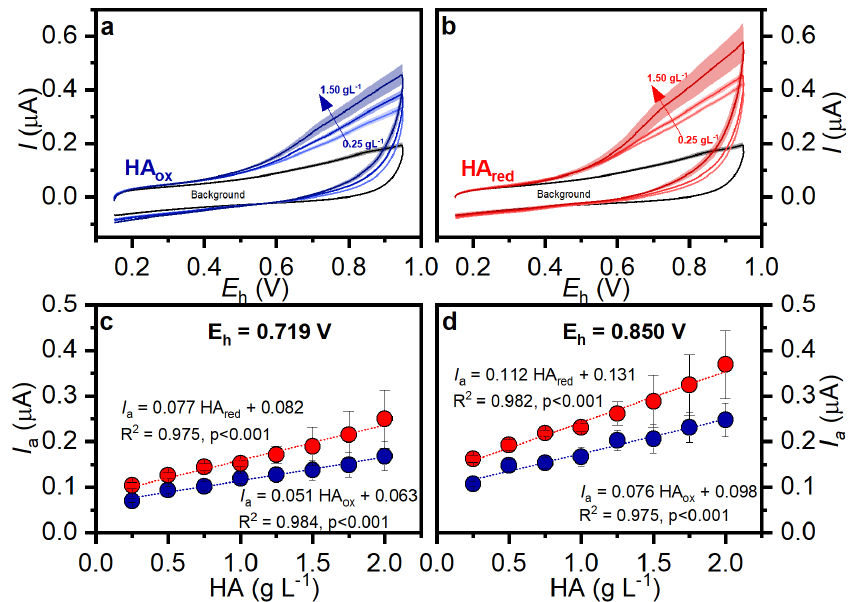
Figure 2. Cyclic voltammograms (CVs) of solutions (0.25, 0.50, and 1.50 g L − 1 ) of HA ox ( a ) and HA red ( b ). Black traces represent the CV of the background electrolyte. Diagrams below report linear correlations between anodic currents at 0.719 V ( c ) and 0.850 V ( d ) versus HA ox (blue symbols) and HA red (red symbols) concentrations.